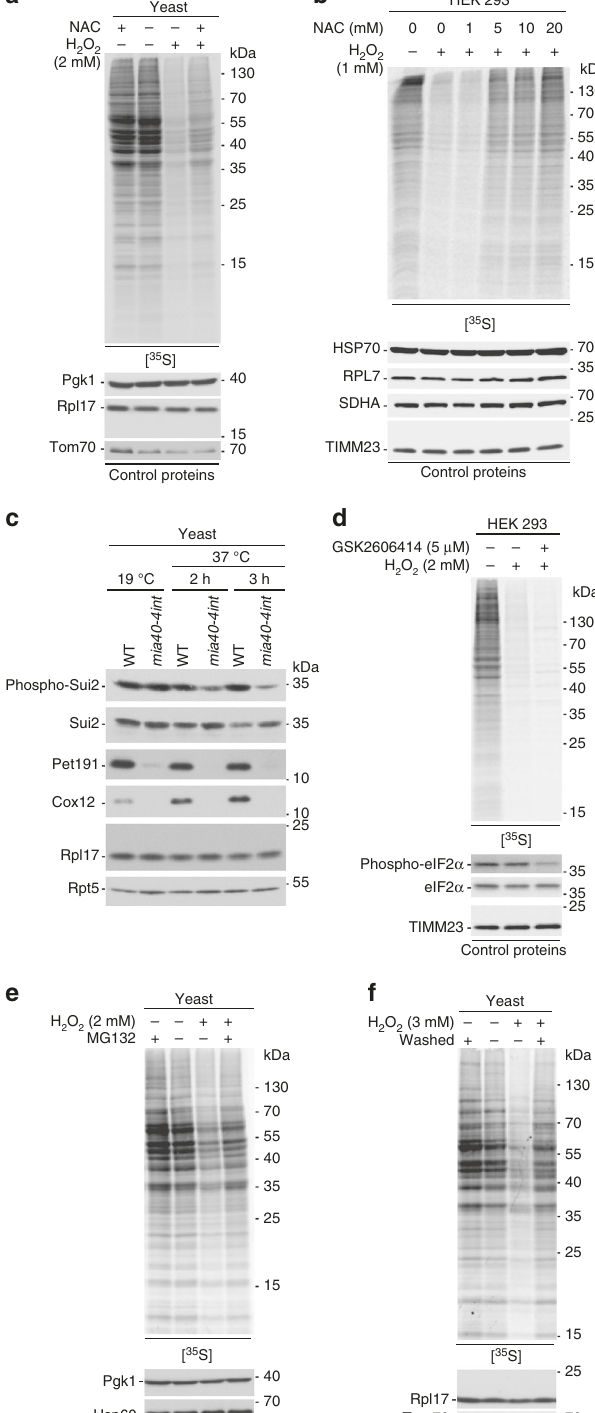
Fig. 7 Translation initiation block is not responsible for inhibitory effect of ROS. a , b , d – f Incorporation of [ 35 S]-labelled amino acids in yeast or mammalian cells. Total cell extracts were separated by SDS-PAGE and analysed by autoradiography or immunodecorated with speci fi c